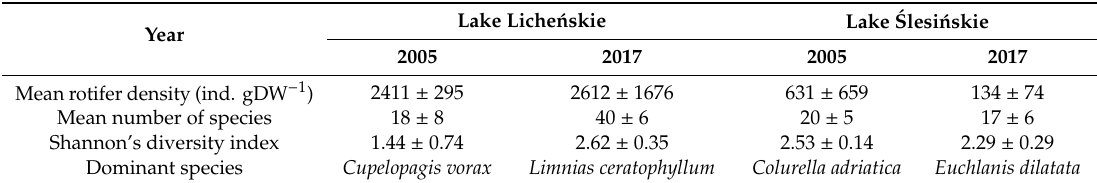
Table4. Quantitative and qualitative characteristics of epiphytic rotifer communities inLakes Liche´nskie and ´Slesi´nskie in the years 2005 and 2017 (mean ±